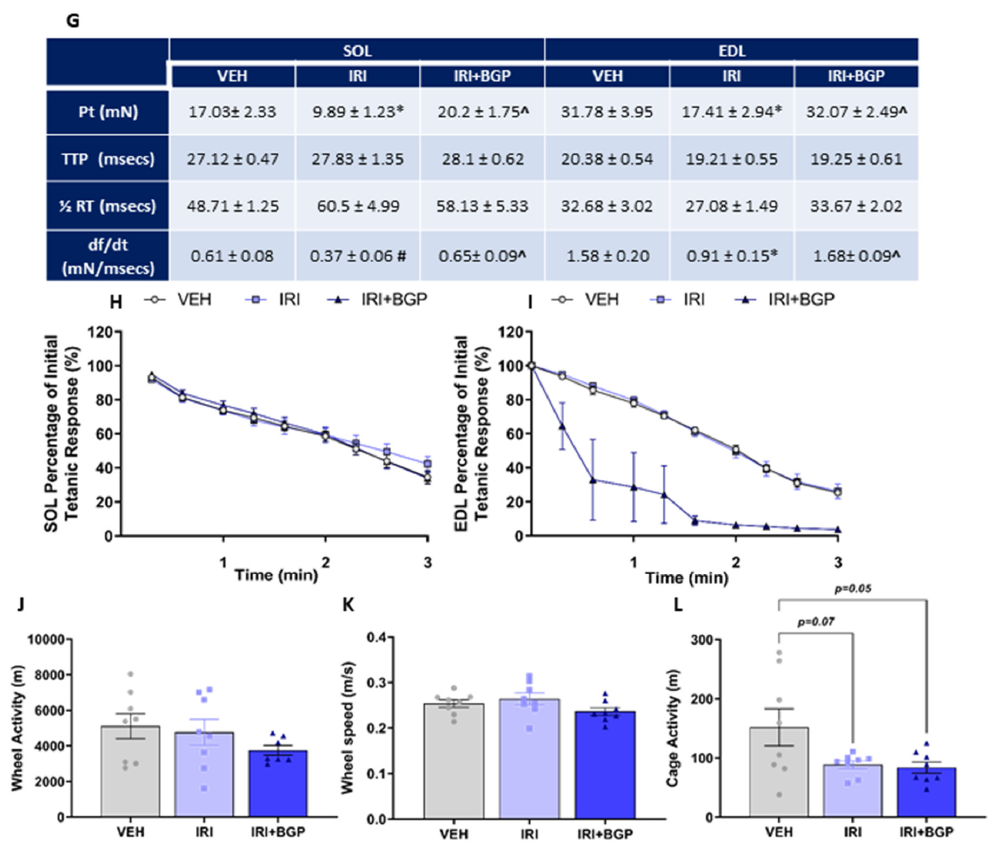
Figure 5. The effect of irinotecan (IRI) and IRI with BGP-15 (IRI+BGP) treatment on skeletal muscle function. Soleus (SOL) and extensor digitorum longus (EDL) muscles underwent ex vivo assessment of contractile function, with ( A , B ) force–frequency relationships and ( C , D ) absolute and ( E , F ) specific